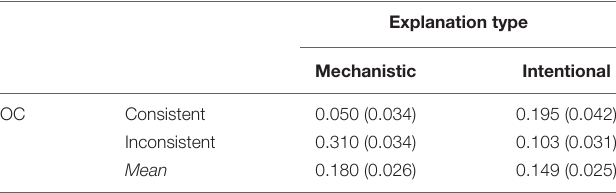
TABLE 2 | Overconfidence (OC) for explanation type and